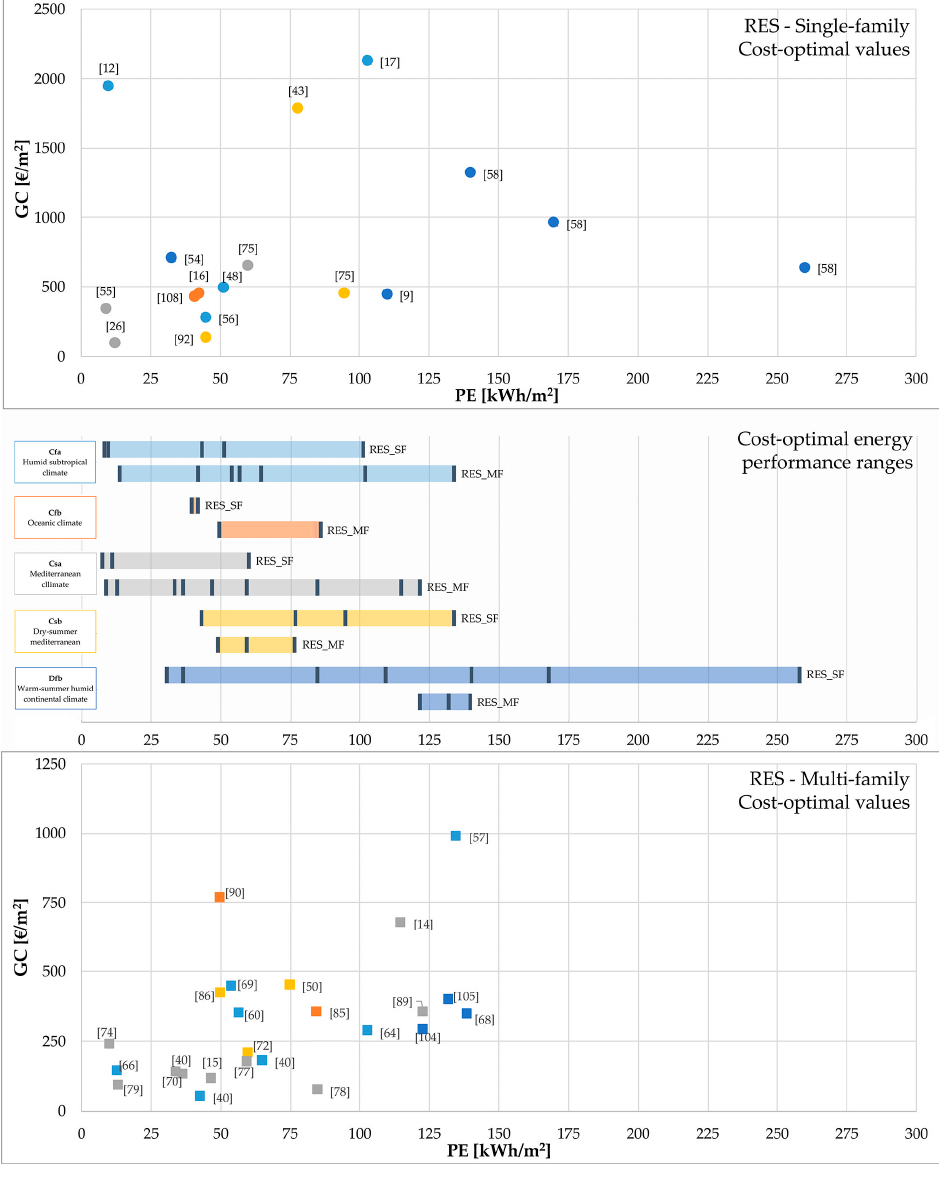
Figure 19. Global cost values and cost-optimal energy performance levels for residential buildings.